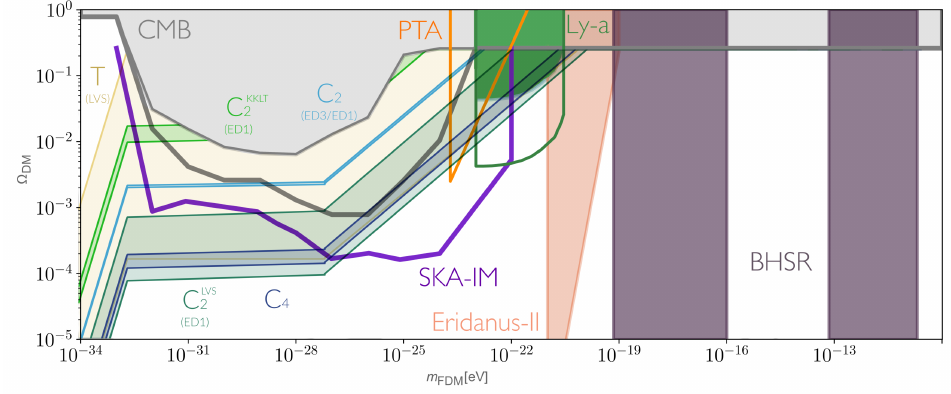
Figure 9 . Mass and total DM abundance predictions for large cycles C 4 axions (blue stripe), C 2 axions (light blue stripe for ED3/ED1 effects, dark/light green stripe for pure ED1 effects in LVS/KKLT), and thraxions in LVS (sand stripe) stabilisation. These results are compared to the current experimental bounds coming from CMB (solid grey area), Lyman- α forest (solid red), Eridanus II (solid pink area) observations and with theoretical predictions based on Black Hole Superradiance (solid purple area). Future experimental bounds coming from CMB (grey), Lyman- α forest detection (red), Square Kilometre Array (brown) and Pulsar Timing Arrays (orange) are identified with solid lines. The reported experimental bounds were adapted from the recent review on ultralight bosonic dark matter [19]. We refer the reader to that text and to the references therein for more details and extended bibliography. Note that axions moderately evading the WGC (thraxions and C axions) are those representing the lightest FDM 2